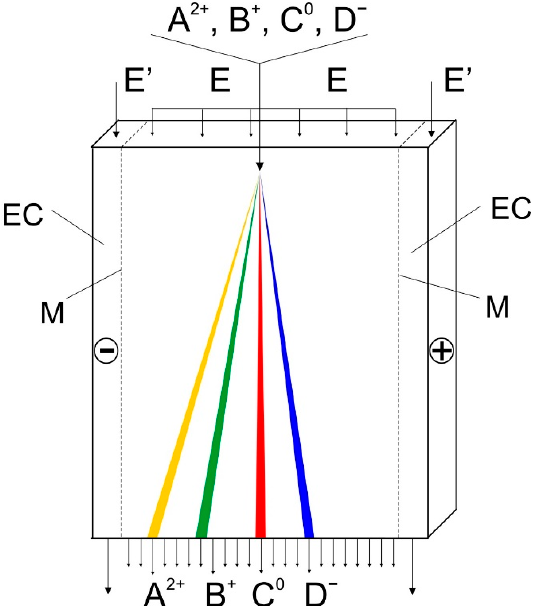
Figure 2. Scheme of the flow-through electrophoretic chamber and principle of the free-flow zone electrophoresis (FFZE). A 2+ , B + , C 0 , and D − , sample components continuously introduced to the injection point of the chamber as a narrow zone and collected at the outlet side of the chamber; E, carrier background electrolyte (BGE) continuously introduced by a laminar flow into the chamber and collected at its outlet side; E’, BGE circulating in the electrode compartments (EC); M, ion-exchange membranes between the separation chamber and the electrode compartments.